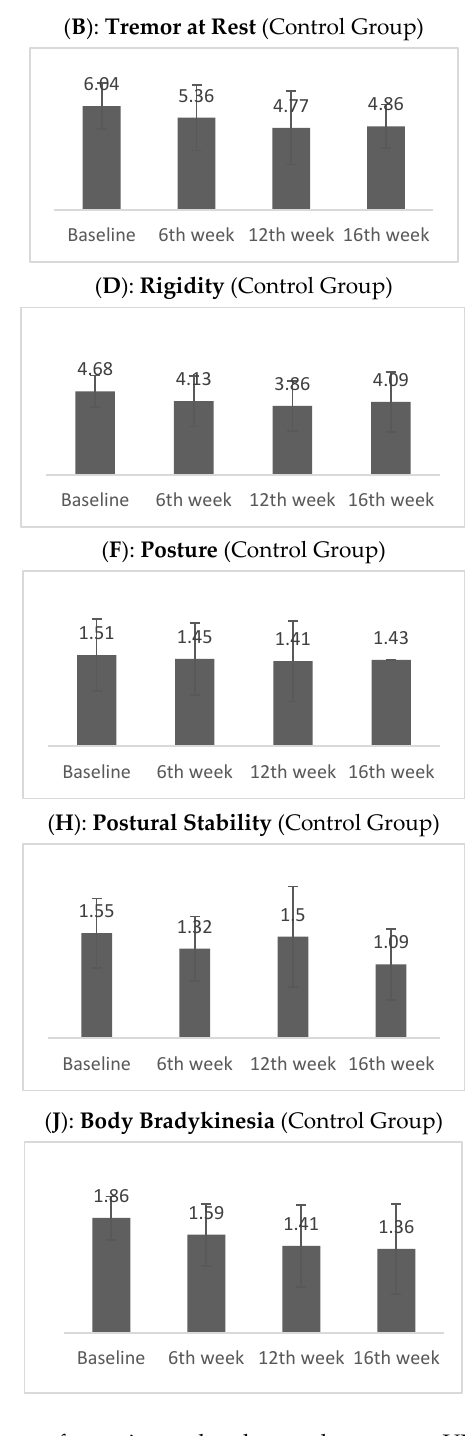
Figure 3. Difference between mean scores of experimental and control groups on UPDRS part